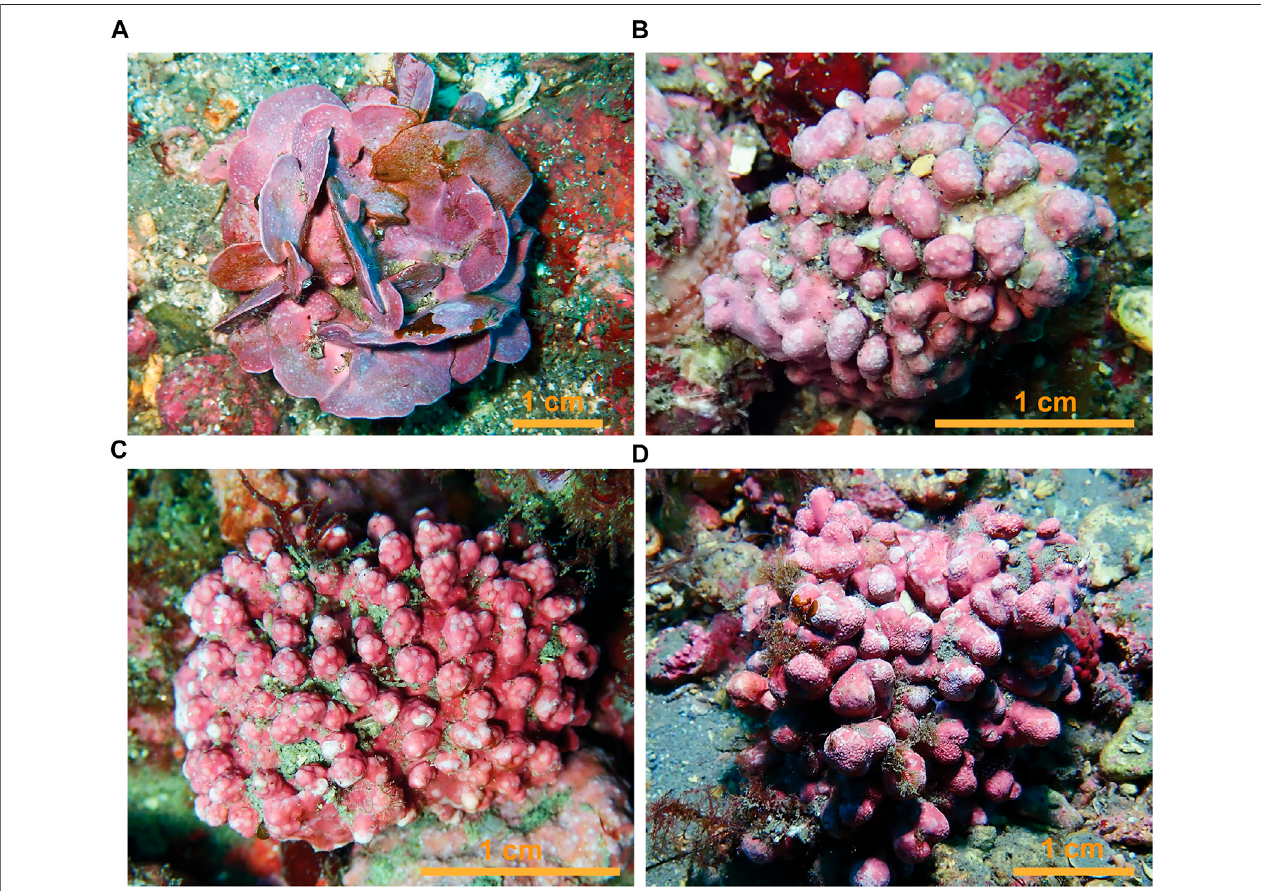
FIGURE 10 | Monospeci fi c rhodoliths: (A) Lithophyllum dentatum ; (B) Lithopyllum racemus ; (C) Lithothamnion minervae ; (D) Lithothamnion valens.